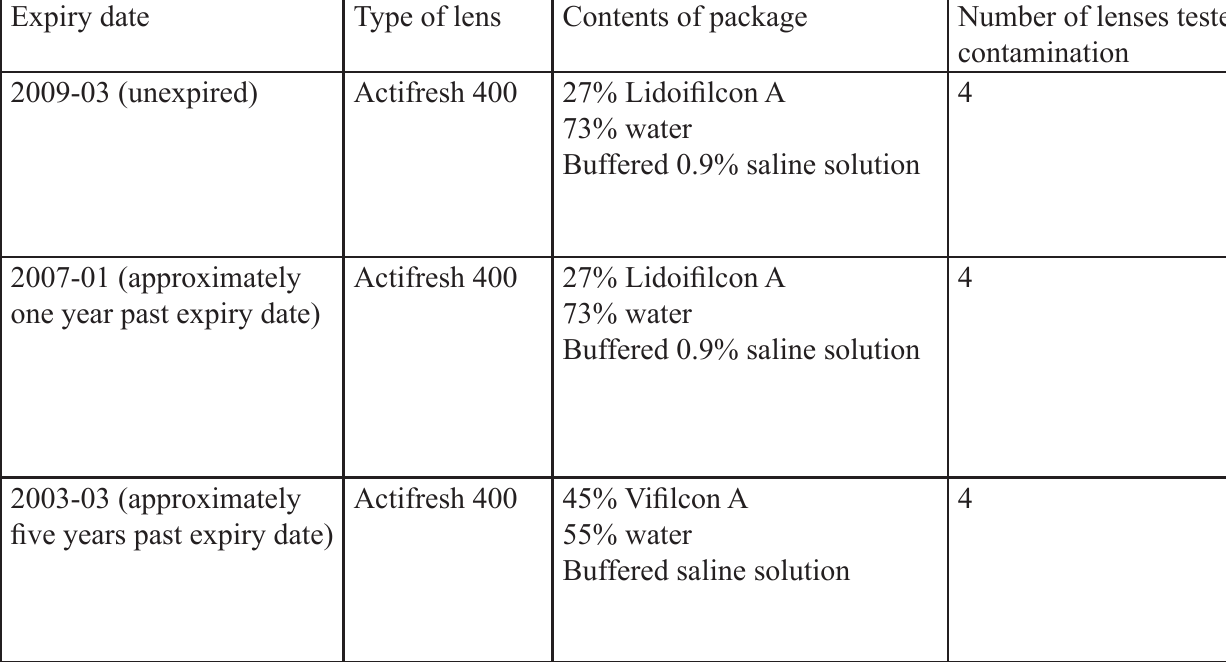
Table 4: Details of Hydron (Cooper Vision) blister pack contact lenses